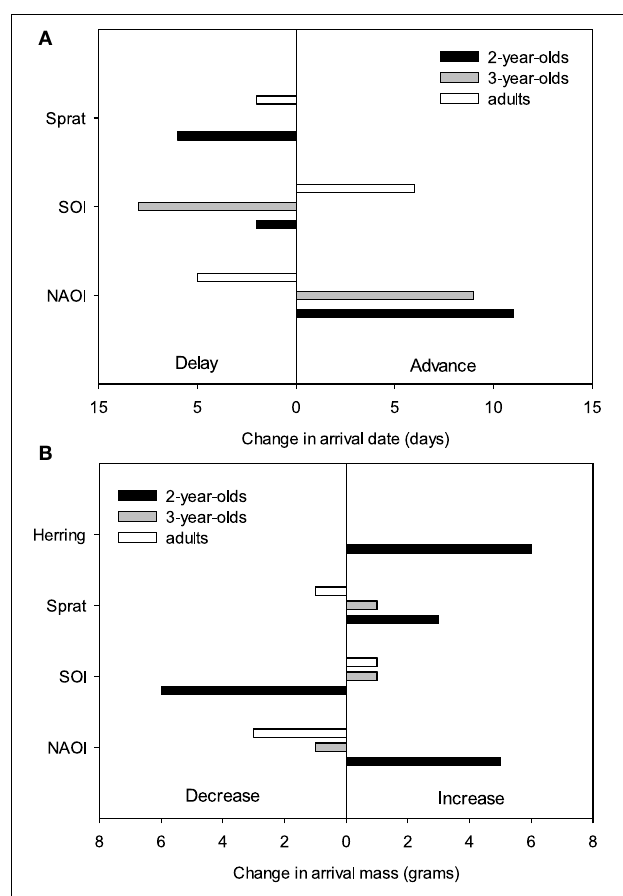
FIGURE 4 | Predicted effects of environmental factors on the change in (A) arrival date (in days, Table 3) and (B) arrival mass (in grams, Table 4) in three age groups (2-year-olds, 3-year-olds and adults) over the observed range of the respective covariates between 1994 and